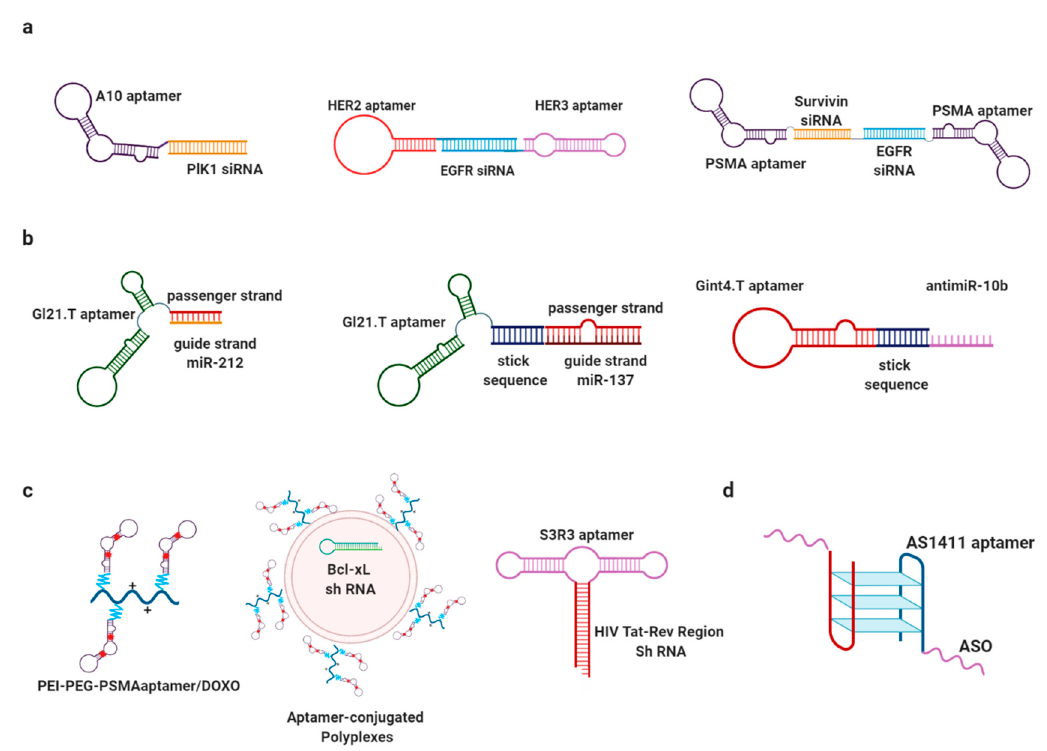
Figure 3. Schematic presentation of principle Aptamer ‐ chimeras. Main examples of the mentioned chimera conjugates (aptamer ‐ siRNA ( a ), aptamer ‐ miRNA/antimiRNA ( b ), aptamer ‐ sh ( c ) and aptamer ‐ ASO ( d )) are schematically illustrated.